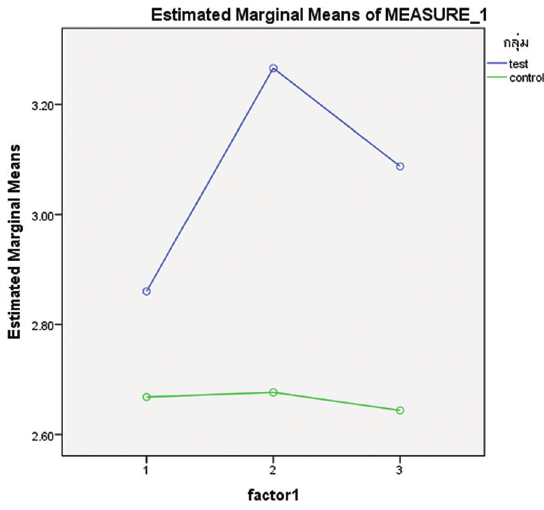
Figure 1. The present study showed a mean difference in self- management program scores between the experimental and control groups at the fourth week after entering the